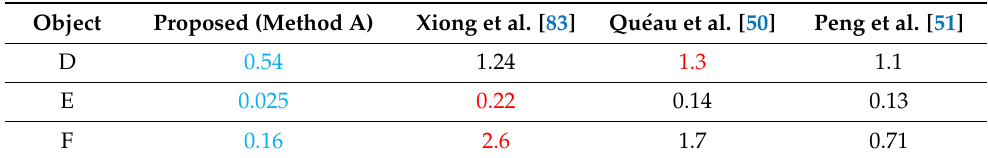
Table 5. Comparison of the proposed method to three state-of-the-art approaches. The results are in millimeters. The blue values represent the best performance and the red values represent the lowest